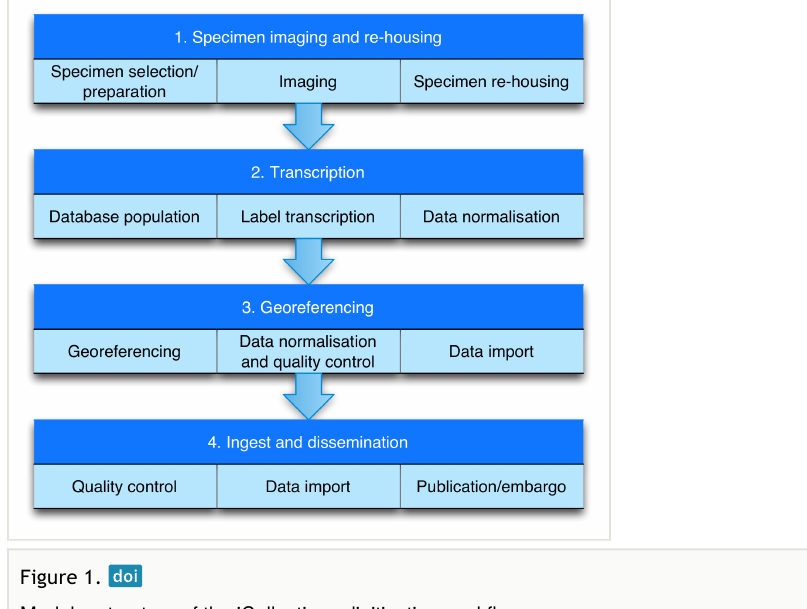
Modular structure of the iCollections digitisation work fl